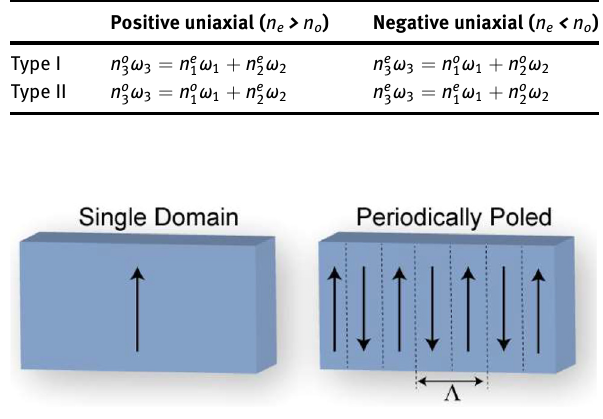
Figure 3: A crystal with a single domain (left) will have a single optical axis. With periodic poling (right) the crystal will have alternatingopticaxiswithaperiodof Λ .Periodically-poledmaterials are frequently used for phase-matching in nonlinear